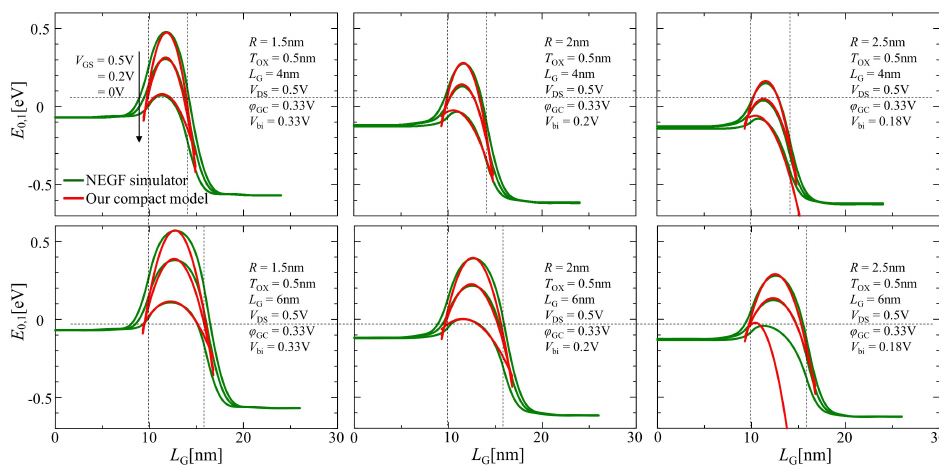
Figure 4. Comparison of the results of the lowest sub-band profile plot between the compact model using Equation (13) and NEGF simulation under different gate bias